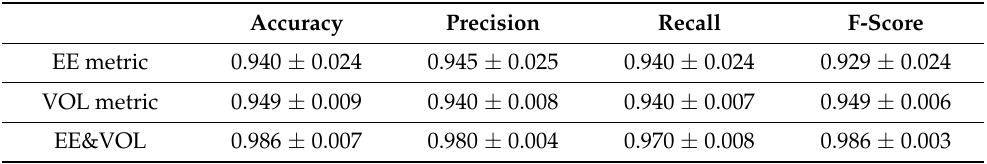
Table 5. Performance metrics of transfer learning models on high-entropy compounds using eightfold validation.